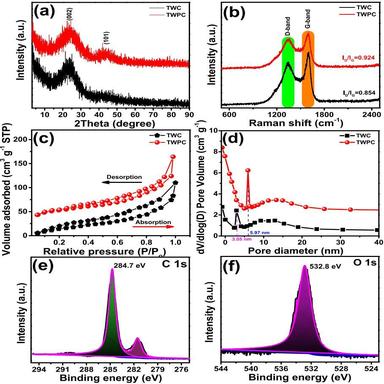
(a) XRD patterns, (b) Raman spectra, (c) nitrogen adsorption-desorption isotherms and (b) pore-size distributions of the as-prepared TWC and TWPC and (e,f) high resolution XPS spectra of TWPC sample: (e) C 1s and (f) O 1s.